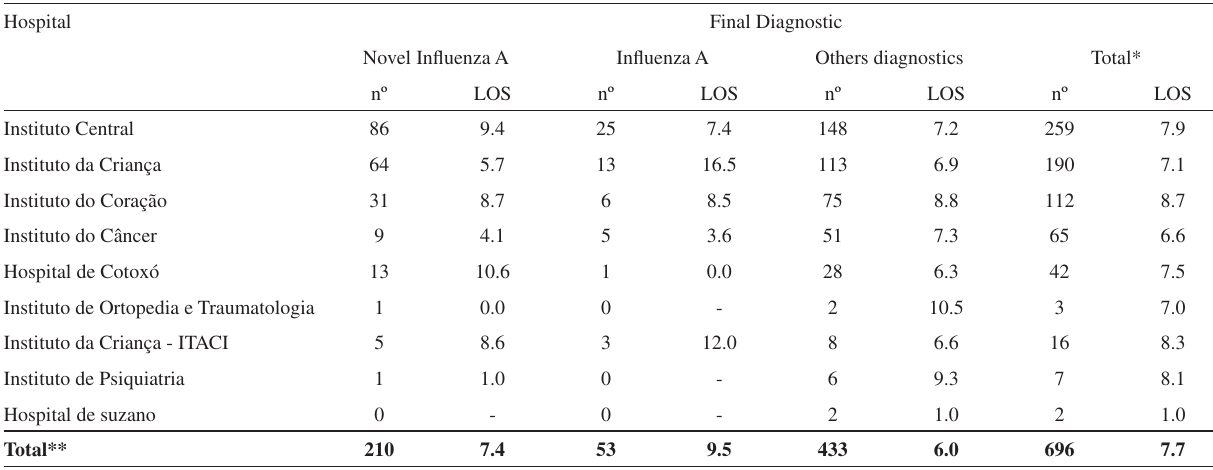
Table 4 - Number of hospitalized patients with novel Influenza H1N1 and length of stay according to the Institute or associ- ated Hospital in the HC-FMUSP- June 16, to September, 18 - 2009